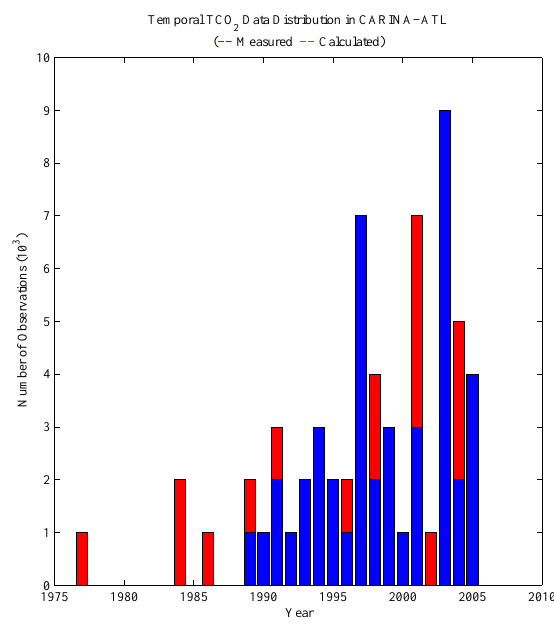
Figure 3. Temporal TCO 2 data distribution (measured in blue and calculated in red) in the CARINA Atlantic data